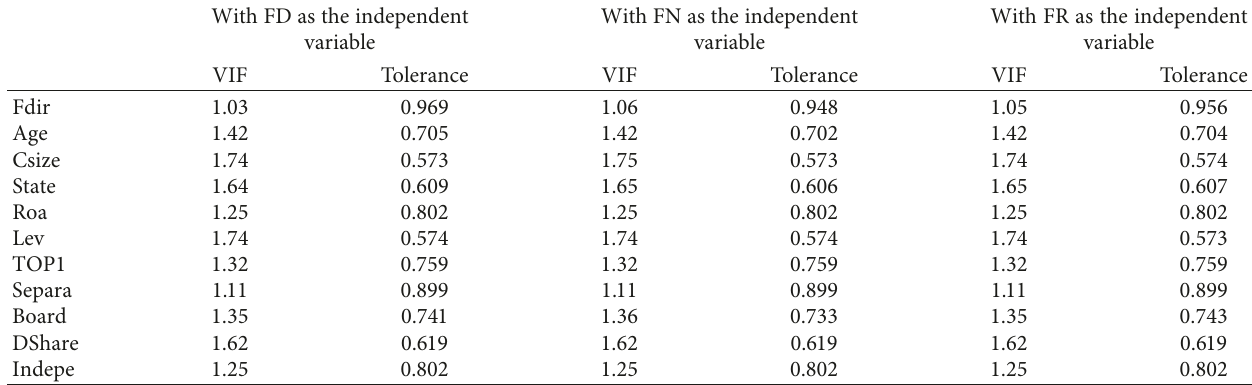
Table 8: Test results of variance inflation factor of main effect regression models.